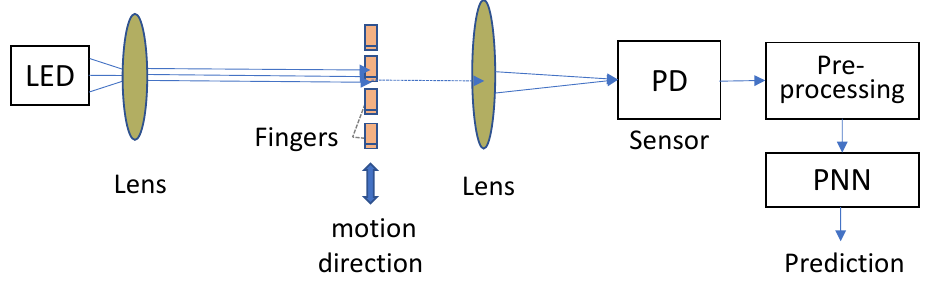
Figure 1. The principle of operation of the finger movement identification system is based on light patterns detected by a sensing photodiode. The received signals are processed by the PNN